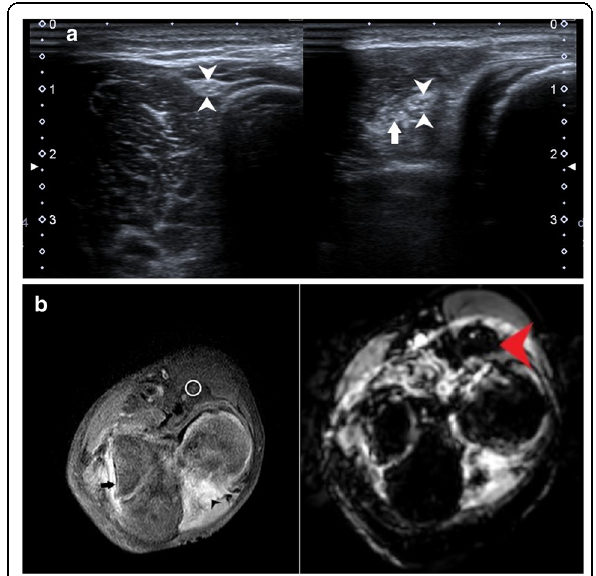
Fig. 10 a Normal radial nerve (between white arrowheads) at the level of the spiral groove on the left with a mildly hypoechoic radial nerve surrounded by echogenic soft tissue (white arrow) in the distal arm as seen in the panel on the right. Based on ultrasound findings, radial nerve entrapment in scar tissue or hematoma was suspected. b The radial nerve (encircled), just before its division into the superficial and deep components is hyperintense on PDFS image with surrounding hypointense soft tissue. There are also changes of haemophilic arthropathy as evident by the hyperintense joint effusion (arrowheads), cortical irregularities and cartilage thinning (black arrow). On corresponding SWI image, there is blooming in the area around the radial nerve, which corresponds to the echogenic soft tissue on ultrasound (red arrowhead). This was a case for radial neuropathy due to entrapment in local hematoma in a case of